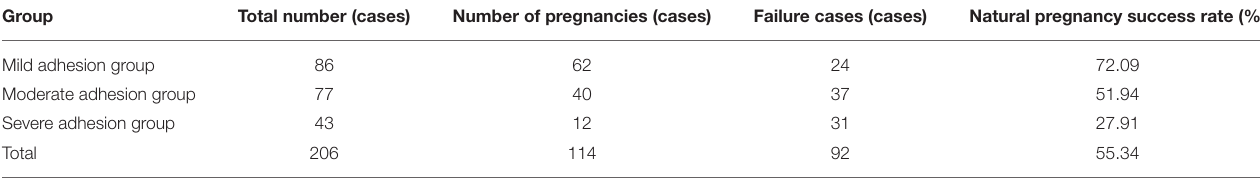
TABLE 1 | Pelvic adhesion and postoperative pregnancy outcome.